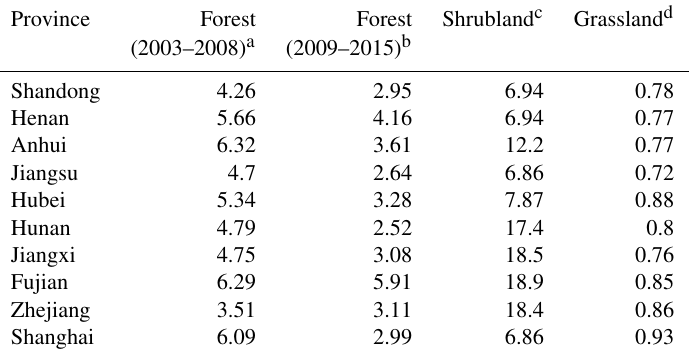
Table 1. Forest, shrubland and grassland biomass fuel loading (ktkm − 2 ) in each